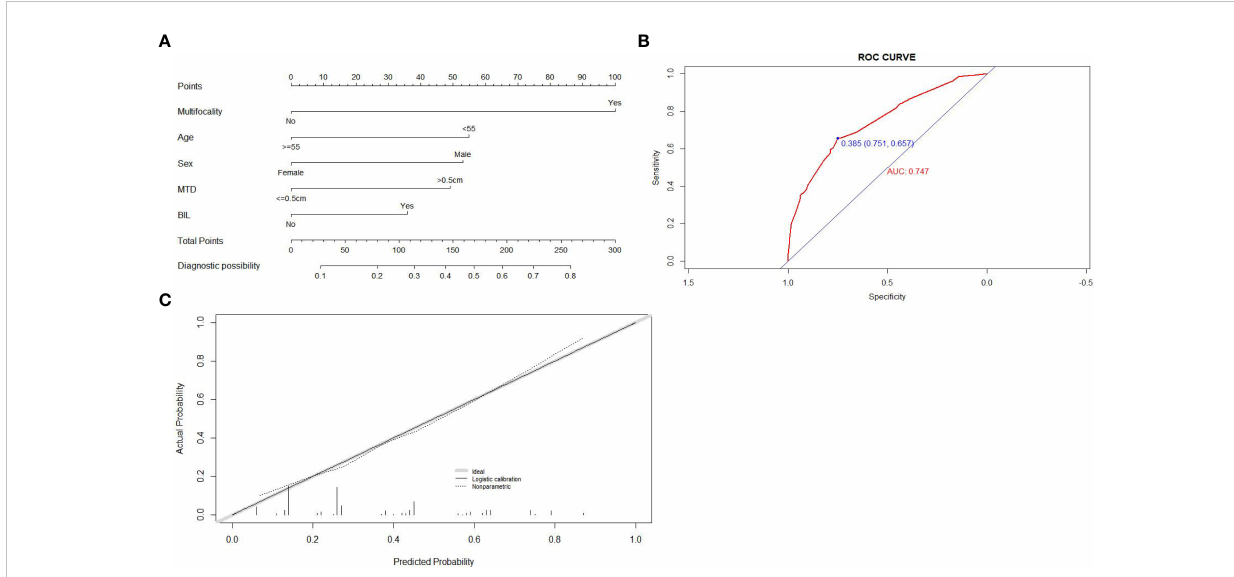
FIGURE 2 Construction, assessment, and validation of the predictive model of CLNM for patients within no-TCI group. (A) The nomograms for predicting CLNM risk in patients within no-TCI group; (B) The ROC curve and AUC of the nomogram for predicting CLNM risk in patients within no-TCI group; (C) The calibration curve of the nomogram for predicting CLNM risk in patients within no-TCI group. Actual probability is plotted on the y-axis, and nomogram predicted probability on the x-axis. CLNM, central lymph node metastasis; TCI, thyroid capsular invasion; ROC, receiver operating